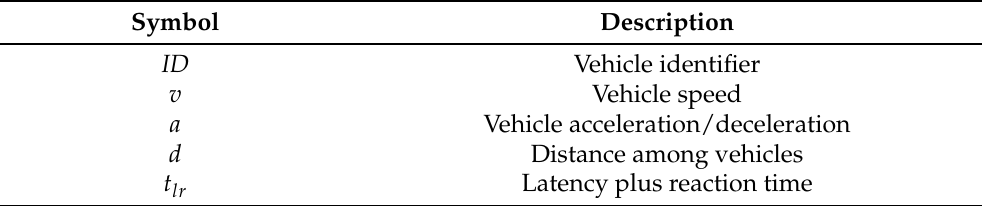
Table 5. Symbols